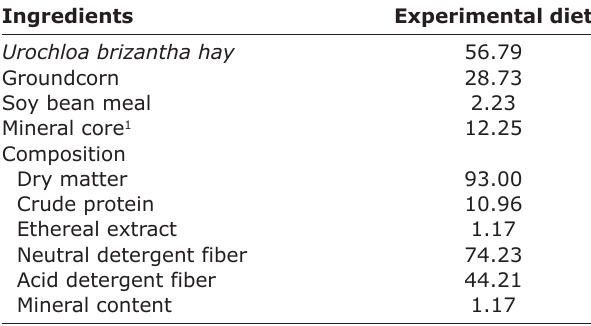
Table-1: Nutritional composition of the experimental diet.